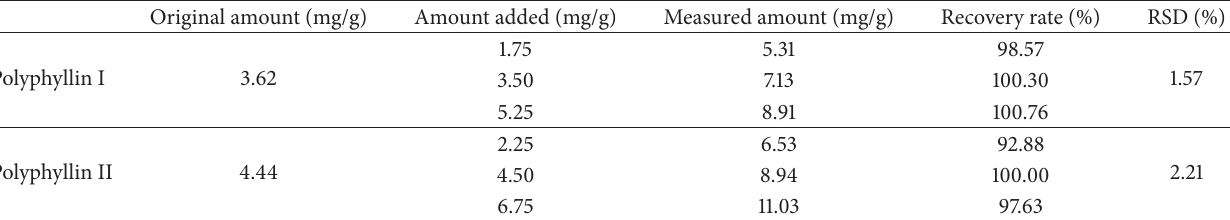
Table 3: Recovery rate of polyphyllin I and polyphyllin